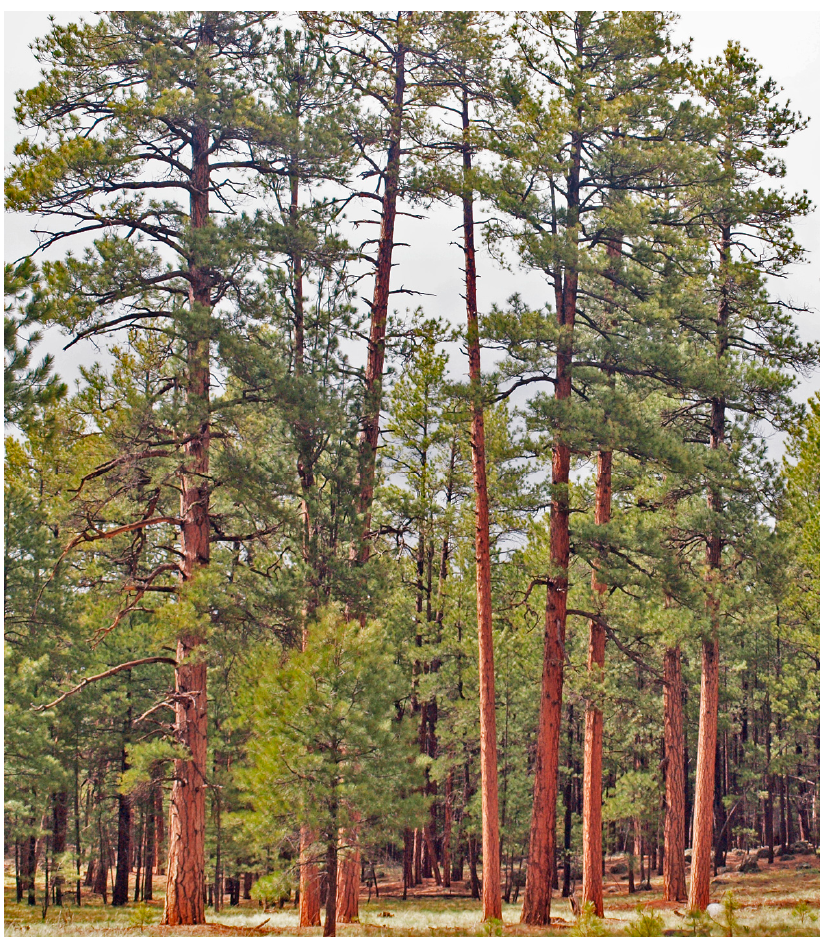
Figure 1. A typical older ponderosa pine forest. Photo by W.L. Baker.